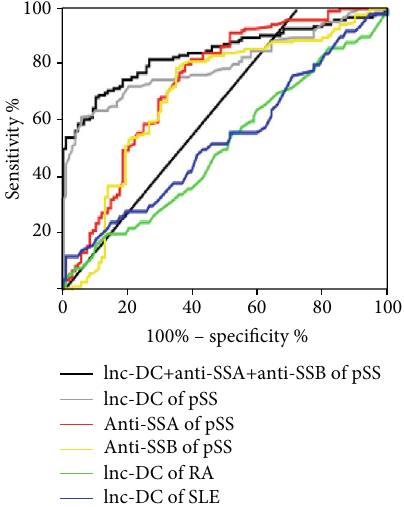
Figure 3: lnc-DC alone or combined with anti-SSA and anti-SSB for the discriminative ability of pSS patients from HC and other autoimmune